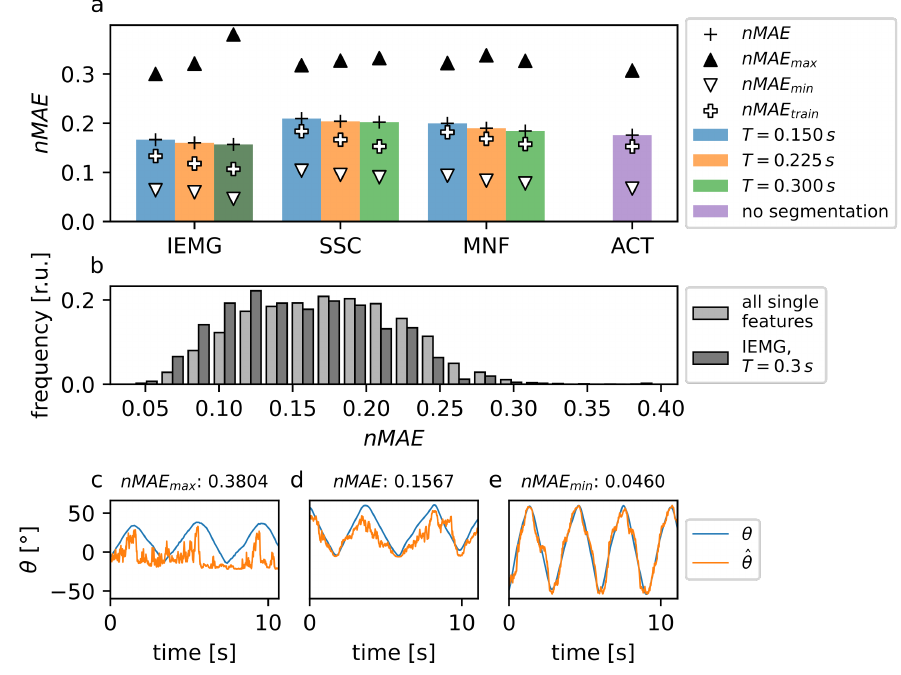
Figure 5. Performance of FFNN models in predicting elbow-joint movements based on different single features extracted from sEMG signals with no offset δ and an overlap corresponding to a 100Hz feature signal frequency. ( a ) Mean absolute errors for elbow-motion prediction based on different segment lengths (blue: T = 0.15s, orange: T = 0.225s, and green: T = 0.3s; purple: no segmentation). The different symbols depict the prediction error ( nMAE ) using the test data set ( black plus sign ), the corresponding minimum ( nMAE min ; white arrow ) and maximum ( nMAE max ; black arrow ) prediction errors, as well as the prediction errors for the training data set ( nMAE train ; white plus sign ). ( b ) Normalized frequency distribution of prediction errors for all single features (light gray bars) and the IEMG feature with a segment length of ( T =) 0.3s (dark gray bars), which yielded the highest predictive accuracy ( dark green color in ( a ) ). ( c – e ) Exemplary plots of an experimentally recorded elbow-joint angle θ ( blue ) and the corresponding model prediction ˆ θ ( orange ) based on the IEMG feature with a segment length of ( T =) 0.3 s , which yielded the highest prediction performance: ( c ) prediction with the highest prediction error ( nMAE max = 0.3804), ( d ) model prediction closest to the mean prediction error ( nMAE = 0.1610) and ( e ) model prediction with the lowest prediction error ( nMAE min =